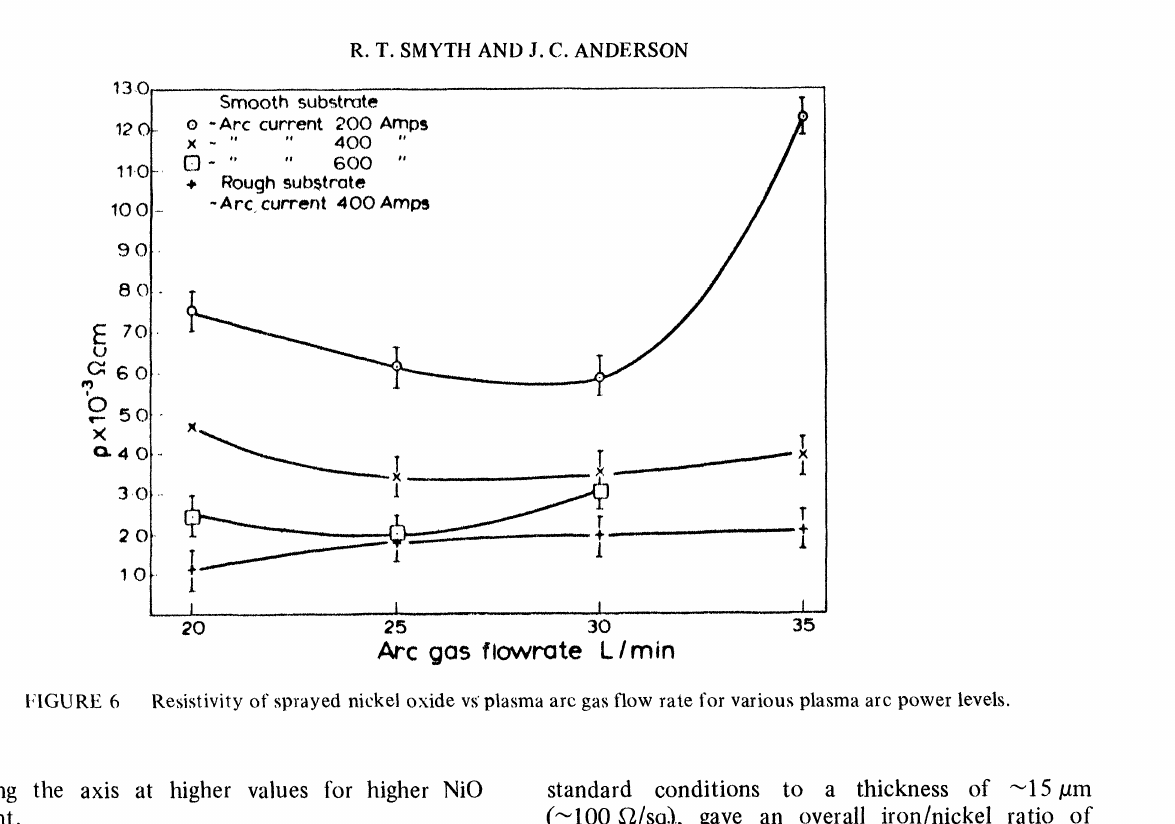
Resistivity of sprayed nickel oxide vs plasma arc gas flow rate for various plasma arc power levels.